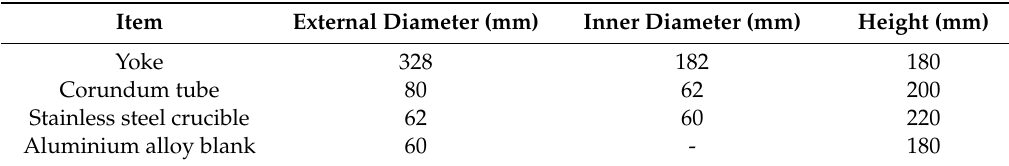
Table 1. Dimensions of the key parts of the electromagnetic stirrer and the aluminium alloy blank.